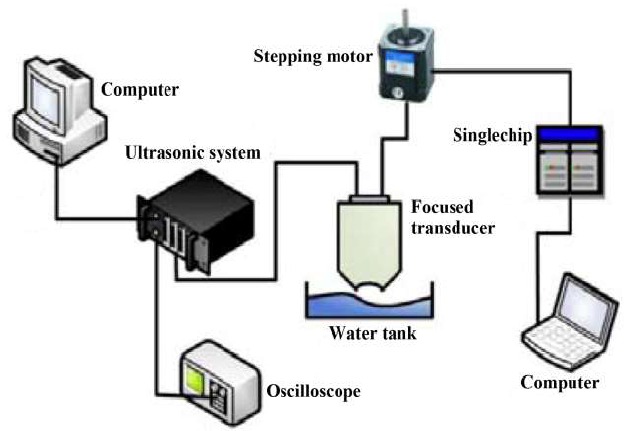
Figure 3. The schematic representation of residual stress measurement system.